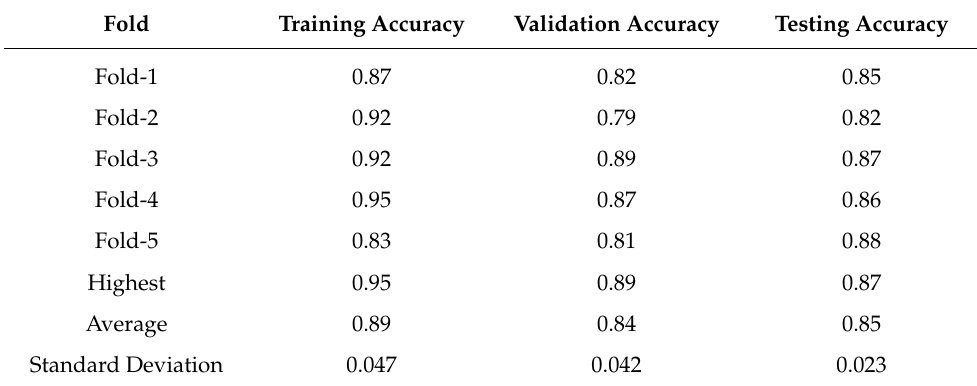
Table 9. Cross validation.